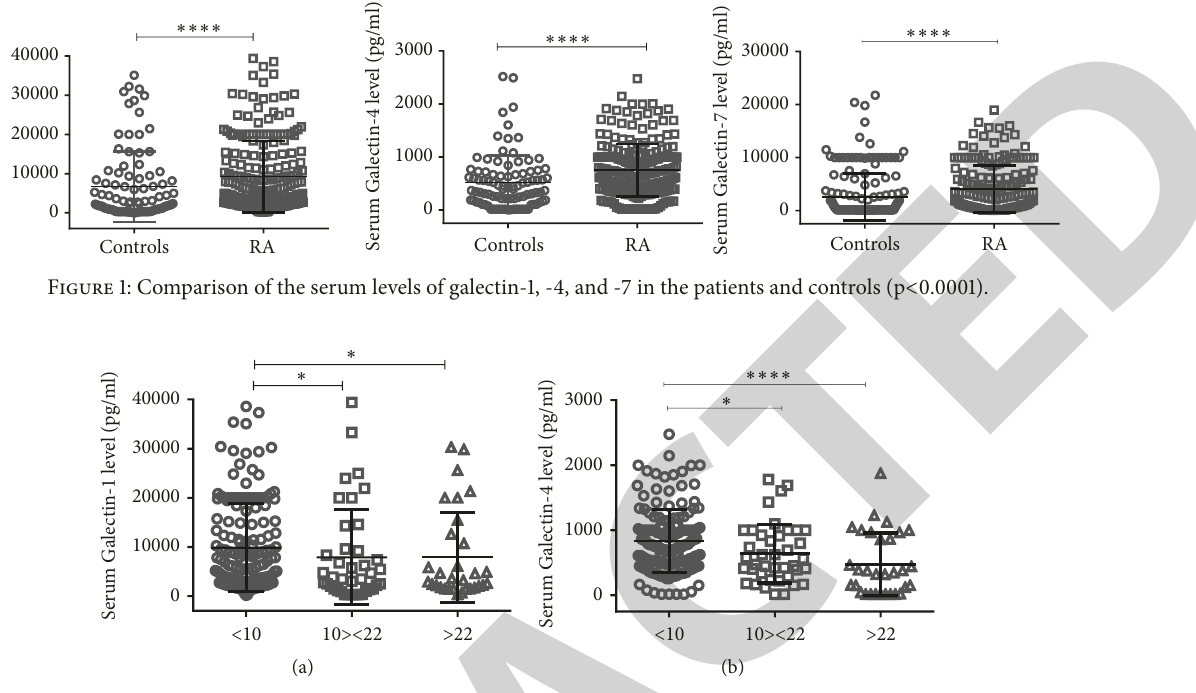
Figure 2: (a) Evaluation of Clinical Disease Activity Index with serum levels of Galectin-1. (b) Evaluation of Clinical Disease Activity Index with serum levels of galectin-4.